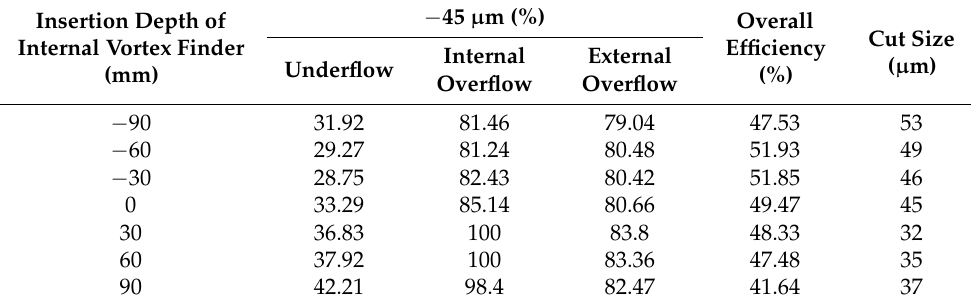
Table 5. Effects of inner vortex finder insertion depth on the separation. Performance of a hydrocyclone. Insertion Depth